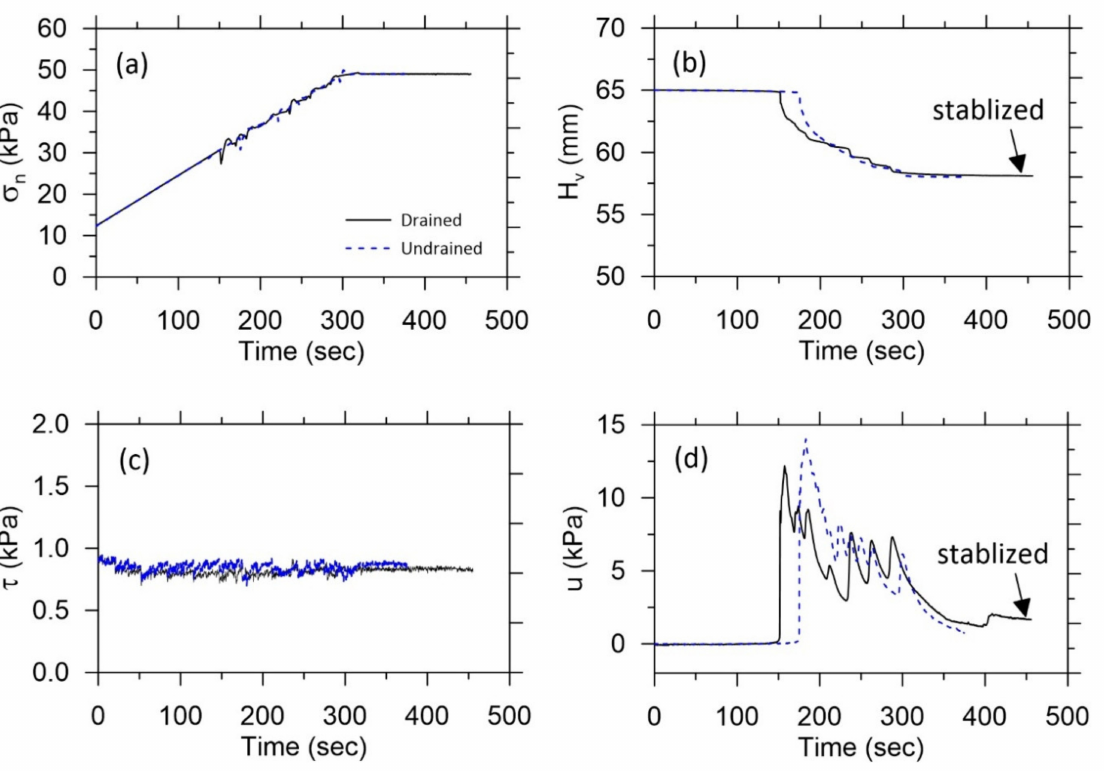
Figure 2. Initial condition for shearing controls in ring shear